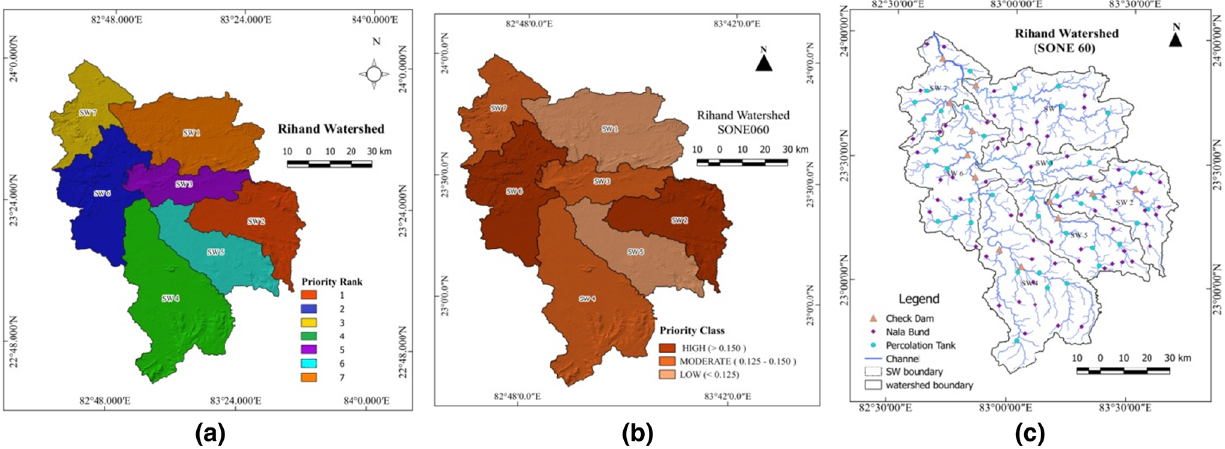
Fig. 9 a , b Prioritization map of the watersheds; c Location for conservation measure